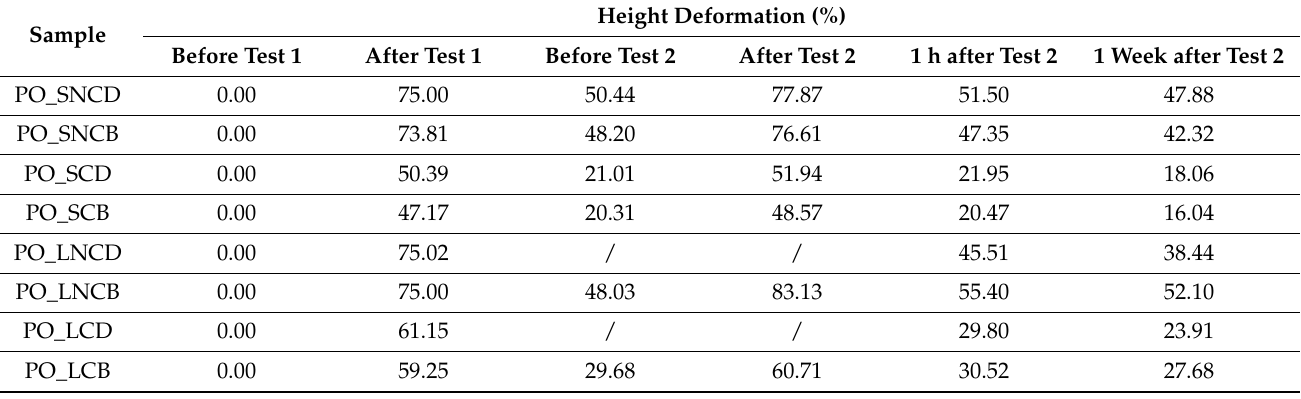
Table 3. This table shows height deformation or strain of samples over time throughout the me- chanical testing process (i.e., before the first test, immediately after the first test, before the second test (which equaled 9 min after the end of the first test), immediately after the second test, one hour after the second test, and one week after the test). Acronyms for each sample are labeled in Table 1.